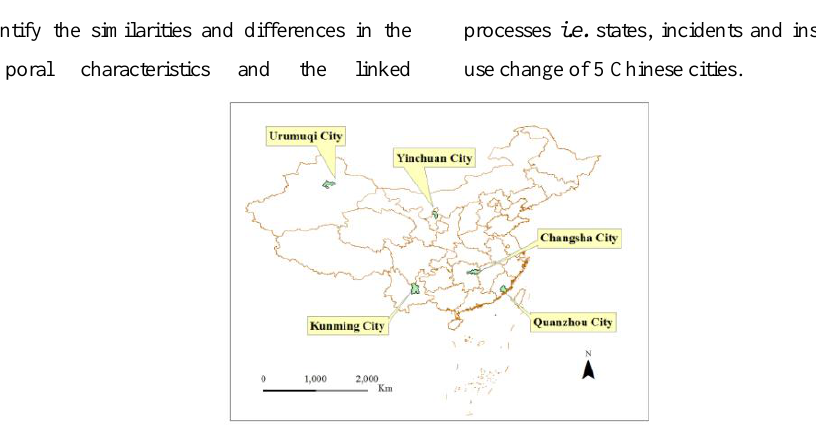
Figure 1. Location map of study area in the Belt and Road of China